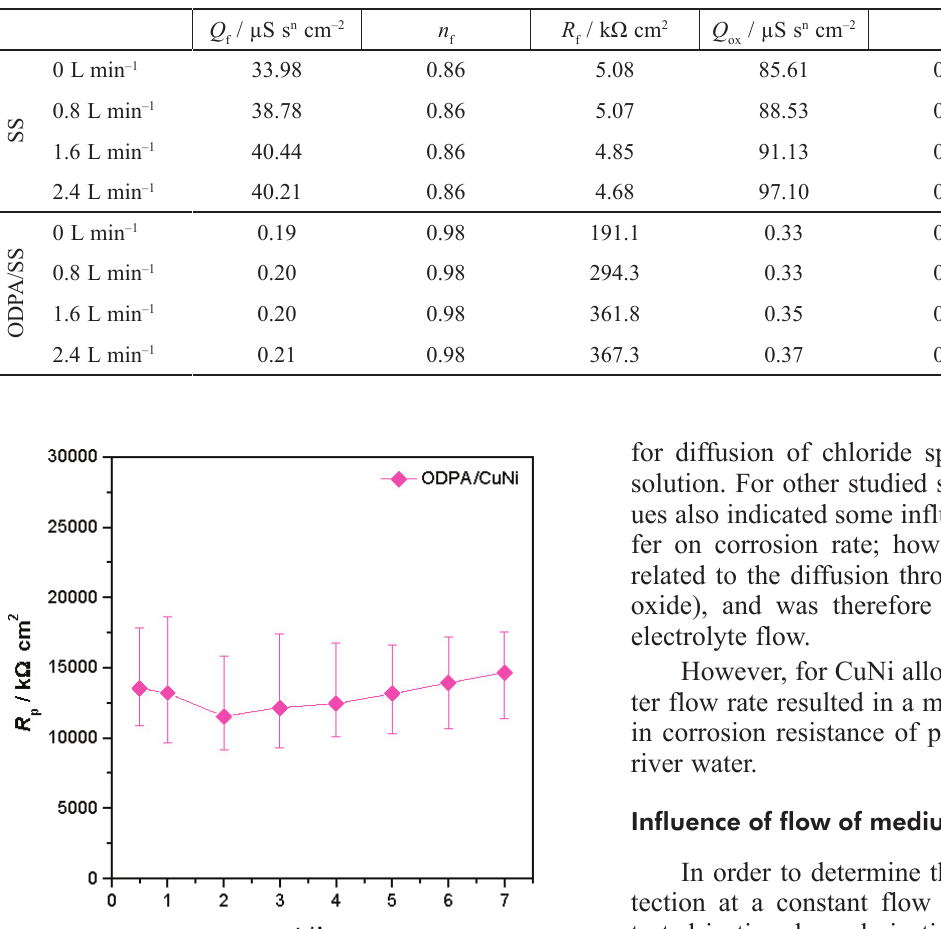
Q / µS s n cm –2 f